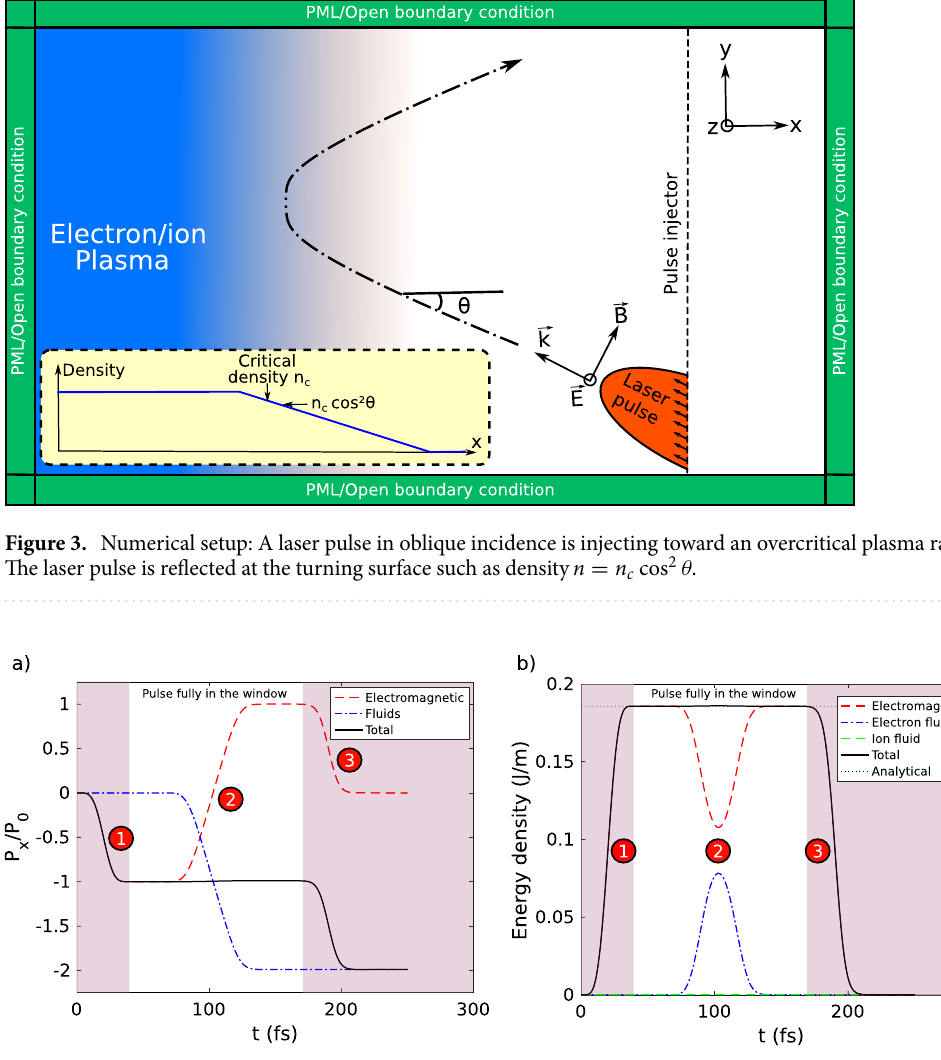
Figure 4. ( a ) Conservation of momentum and ( b ) conservation of energy during s-polarized pulse reflection over the plasma ramp. In the central white area, the pulse is fully in the numerical window and conservation of momentum and energy are